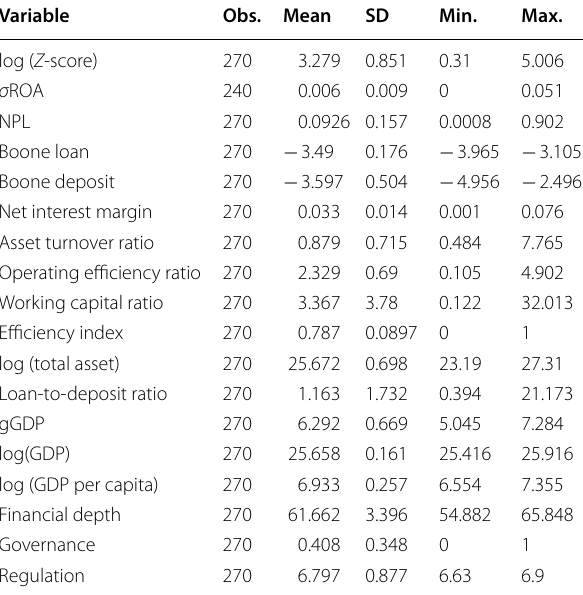
Table 1 Descriptive statistics Table 2 GMM estimation, dependent variable: financial